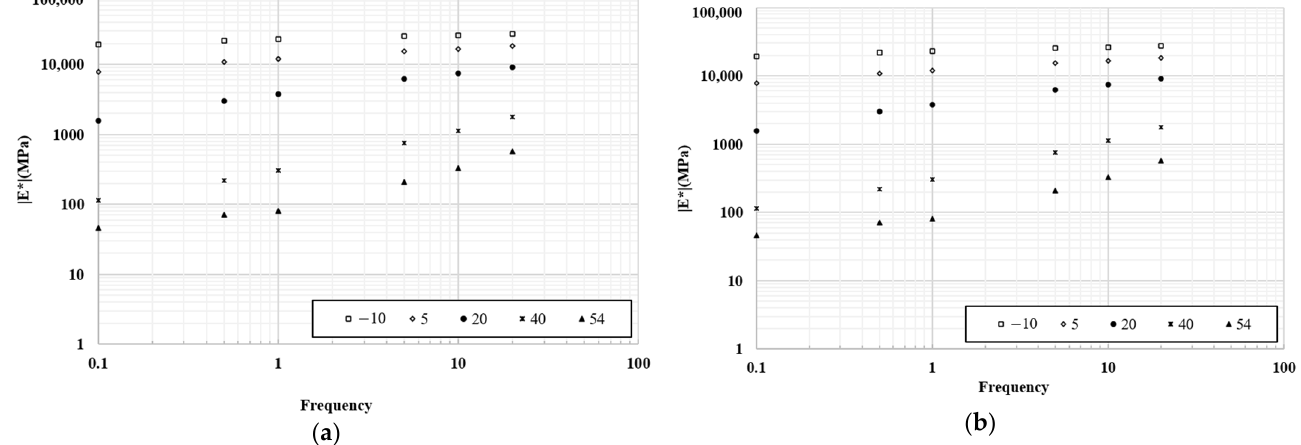
Figure 13. Dynamic modulus results at various test temperatures for mixes: ( a ) RAP-H, and ( b ) RAP-R.